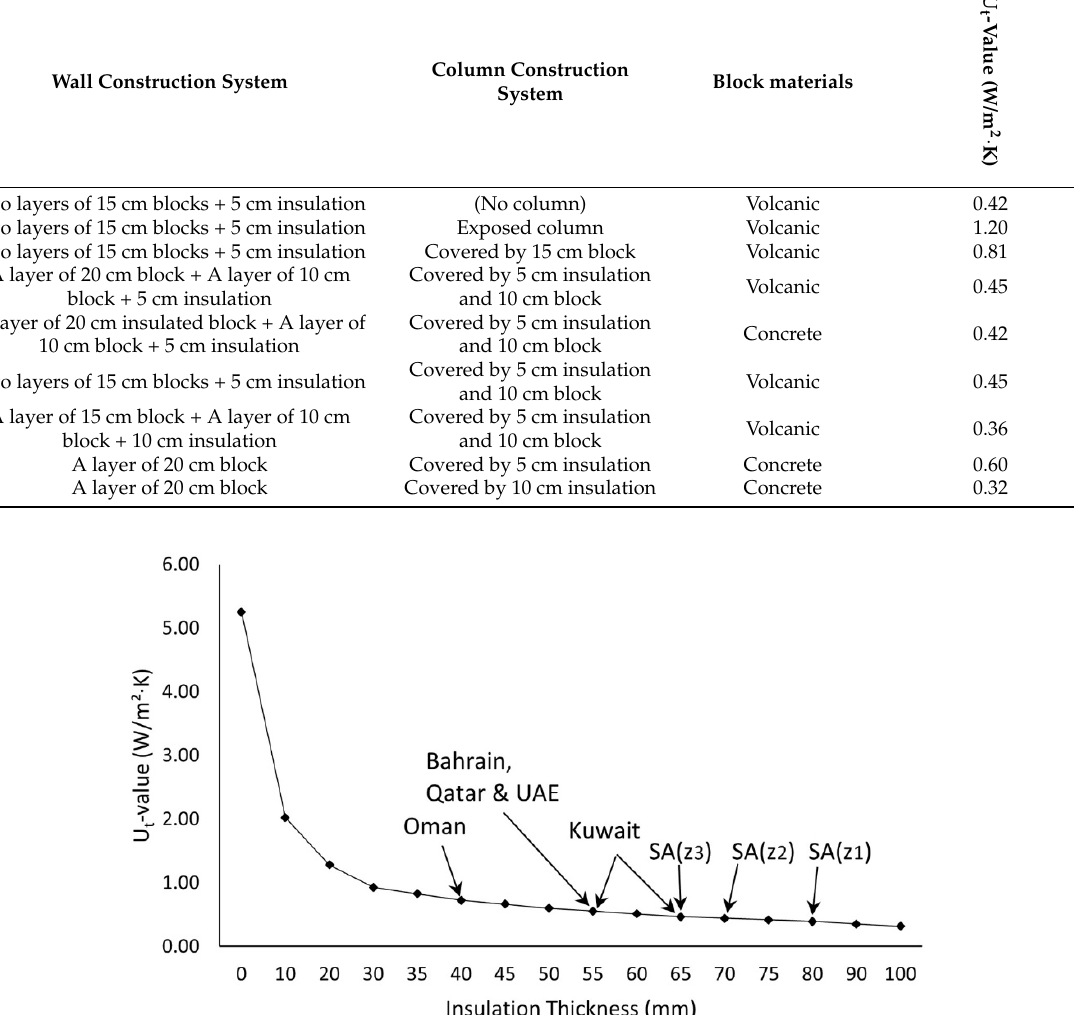
Figure 16. Finite element analysis model. As shown in Figure 17, the percentage of heat flux reduction of using external insu ‐ lation is dramatically decreased as the thickness increases. However, after exceeding a thickness of 100 mm, the reduction of heat flow entering the building is nearly stable, with a decrease of less than 1%. Other researchers showed similar results when they investi ‐ gated the optimum insulation thickness for Saudi Arabia [34,67,68]. Their results show